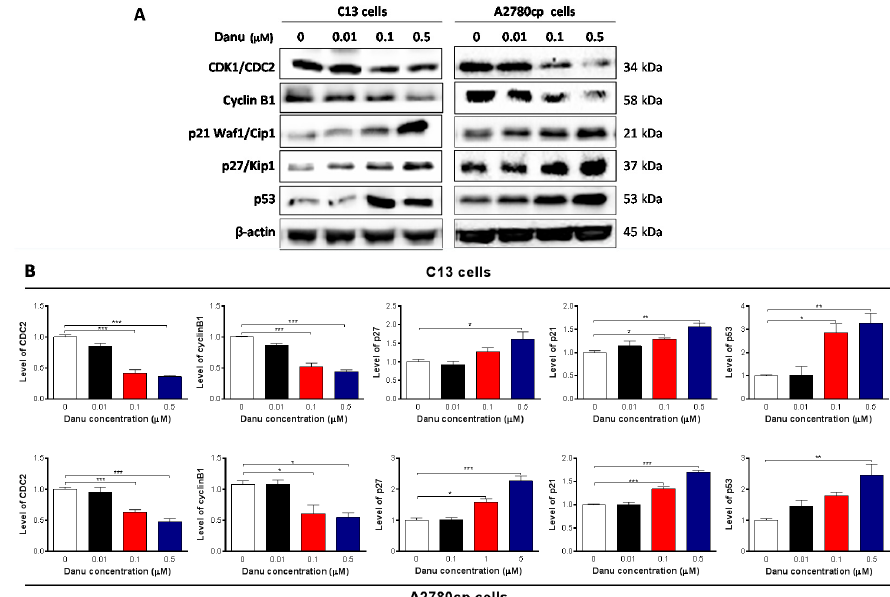
Figure 4. Danu demotes the expression of CDK1/CDC2 and cyclin B1 but promotes the expression of p21 Waf1/Cip1, p27 Kip1, and p53. C13 and A2780cp cells were incubated with Danu 0.01, 0.1, and 0.5 μ M for 24 hours and protein samples were subject to Western blotting assays. ( A ) Representative blots of cyclin B1, p21 Waf1/Cip1, p27 Kip1, and p53 and ( B ) bar graphs showing the relative expression level of CDK1/CDC2, cyclin B1, p21 Waf1/Cip1, p27 Kip1, and p53. β -actin was